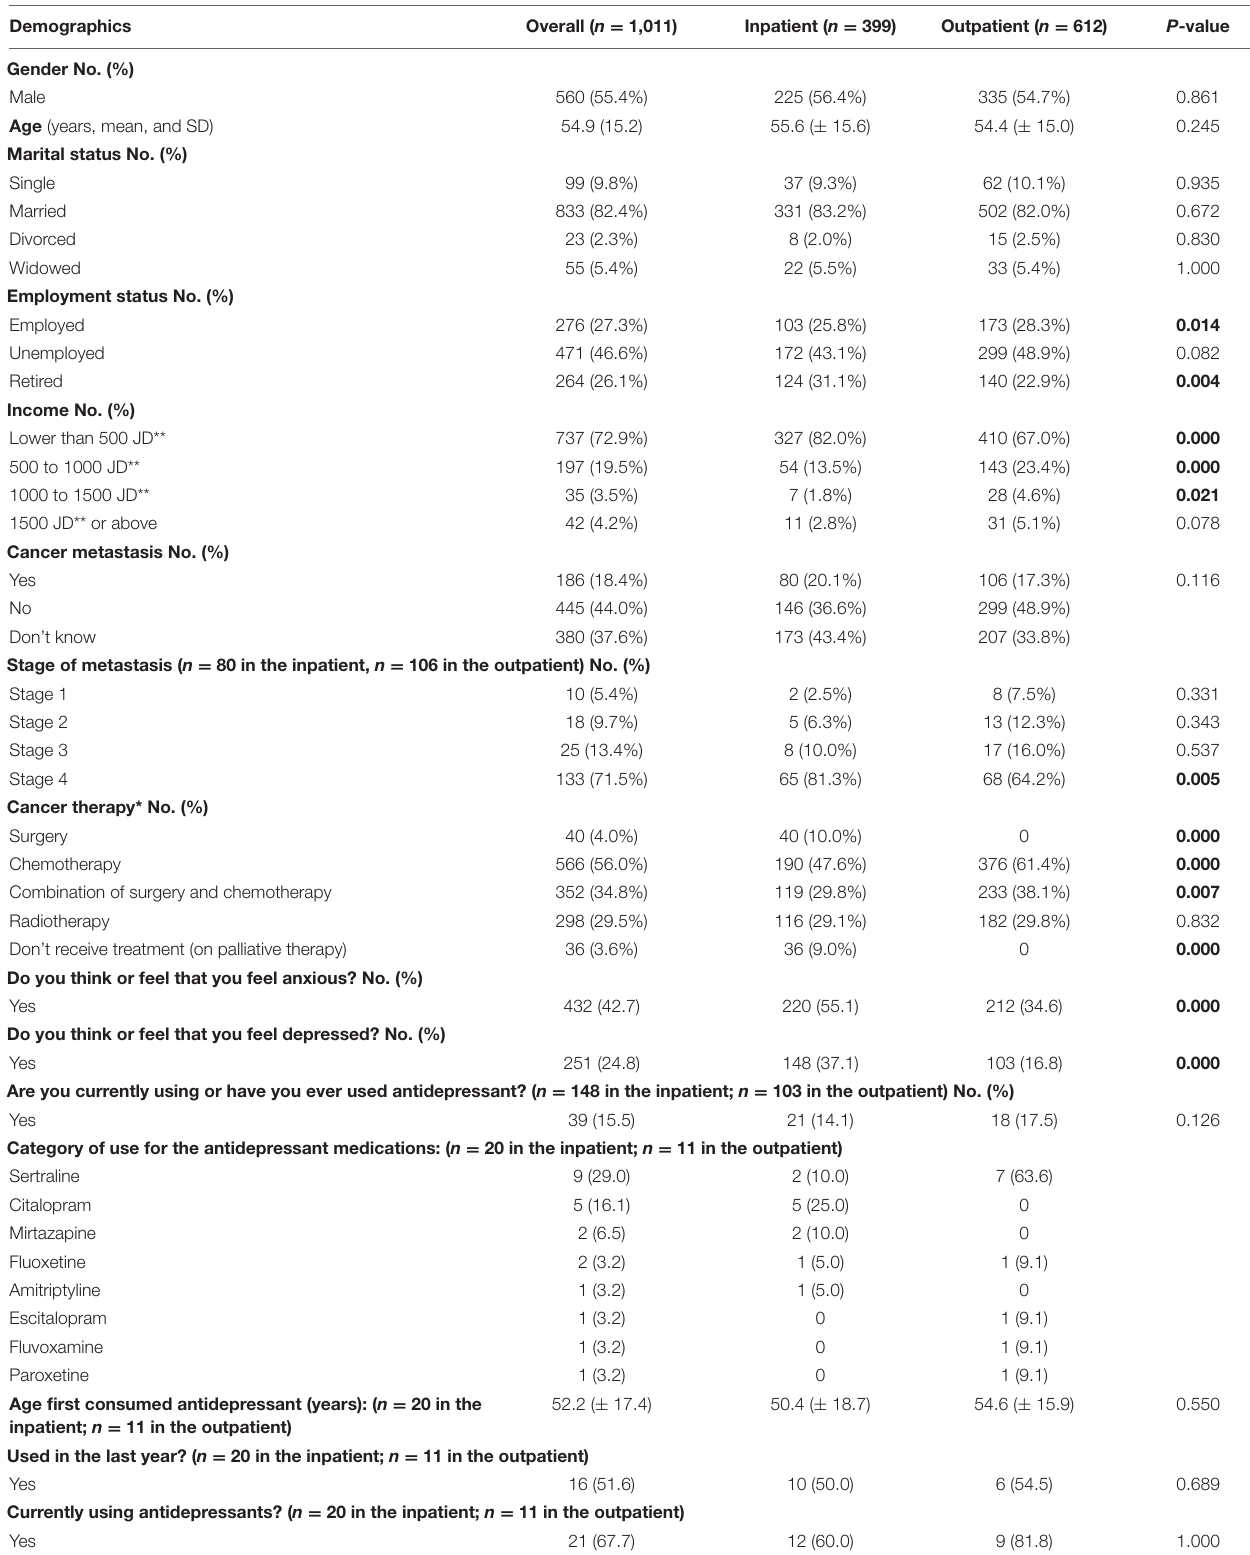
TABLE 1 | The baseline characteristics of the patients in the inpatient and the outpatient settings.